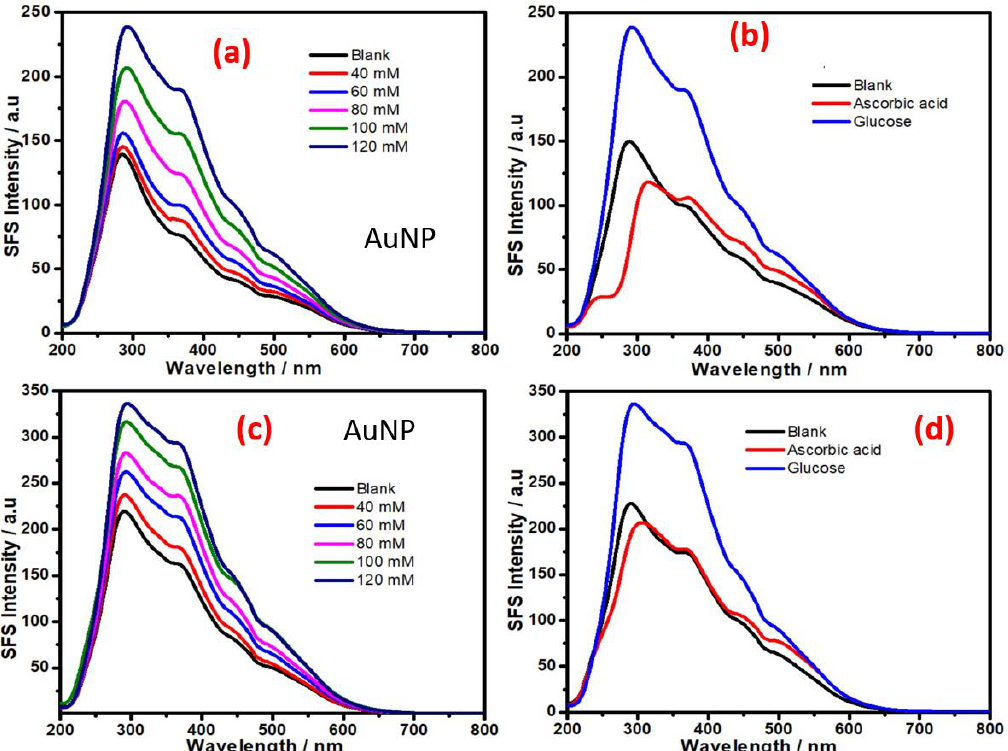
Figure 4. ( a ) Synchronous fluorescence spectra at delta δλ = 0 nm; the spectra were recorded at various concentrations of glucose. ( b ) Synchronous fluorescence intensity of AuNPs in the presence of glucose and ascorbic acid. ( c ) Synchronous fluorescence spectra at delta δλ = 0 nm; the spectra were recorded at different concentrations of glucose with Nafion. ( d ) Synchronous fluorescence intensity of AuNPs with Nafion in the presence of glucose and ascorbic acid.